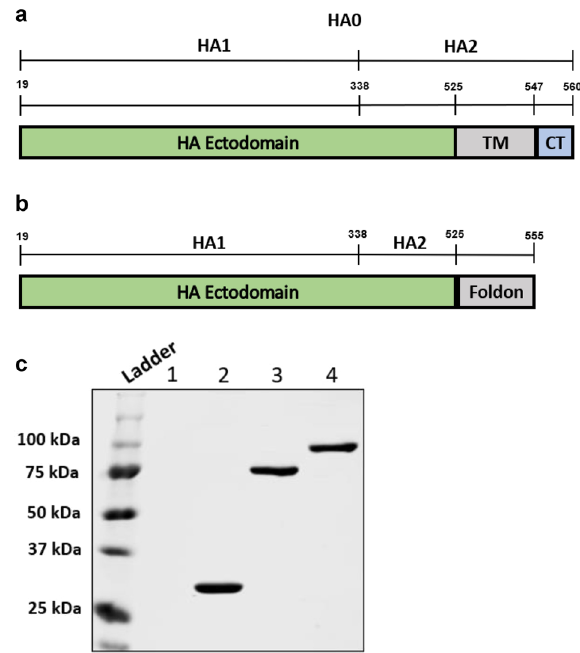
Fig. 1 Construction and puri fi cation of recombinant HA proteins. a Schematic representation of the full length HA protein of H9N2 (MsCon) virus. Precursor HA0 :1-560 amino acids (aa), HA1:19-338 aa, HA2: 339-560 aa, TM = transmembrane domain (525-547 aa) CT = cytosolic tail domain (548 − 560 aa). b Schematic representation of the soluble HA protein of H9N2 (MsCon) virus. The soluble H9HA was generated by removing the TM and CT domains (525-560 aa) and fusing the C-terminus of HA to 30 aa long trimerisation foldon sequence of the trimeric protein fi britin from T4 bacteriophage c His tag puri fi cation of the recombinant proteins. The expected sizes of the puri fi ed CD83 scFv antibody, rH9HA, and rH9HA-CD83 scFv are 30, 70, and 100 kDa respectively. Lane 1: control supernatant from the untransfected cells Lane 2: CD83 scFv Lane 3: rH9HA Lane 4: rH9HA-CD83 scFv. For the puri fi cation of the recombinant proteins, the harvested S2 cell culture supernatants containing recombinant protein bound to the metal ions (copper sulfate was used as an inducer of metallothionein promoter) were loaded onto uncharged “ UNOsphere ” resin derivatized with iminodiacetic acid functioning as a chelating ligand (Pro fi nity ™ IMAC, Bio-Rad). Proteins were eluted with elution buffer containing 50 mM NaH 2 PO 4 , 300 mM NaCl and 50 mM imidazole. The puri fi ed proteins were analysed by 10% SDS- PAGE followed by Coomassie staining. All blots were derived